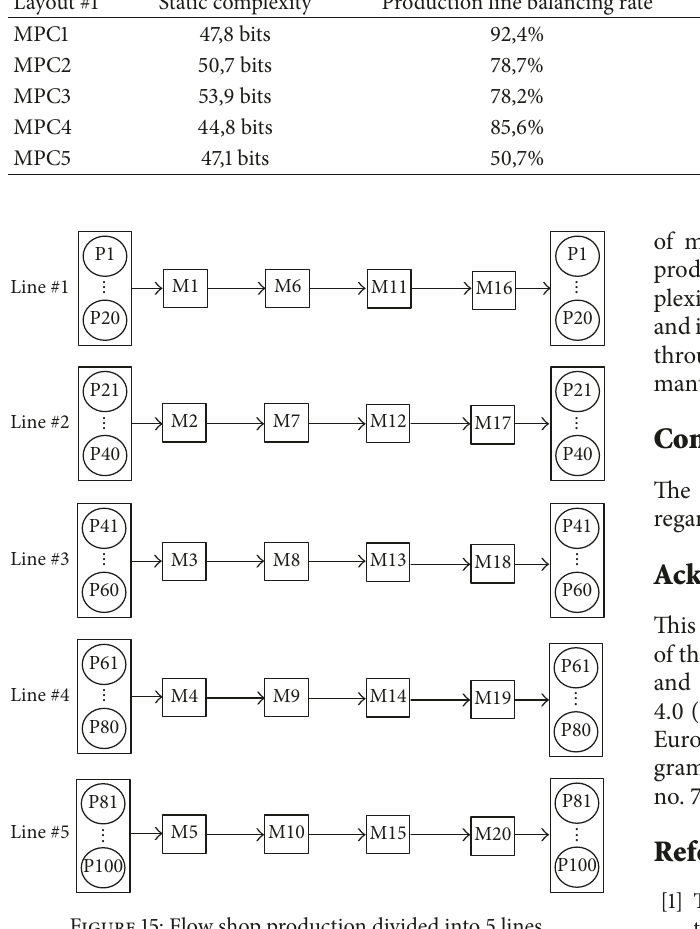
Figure 15: Flow shop production divided into 5